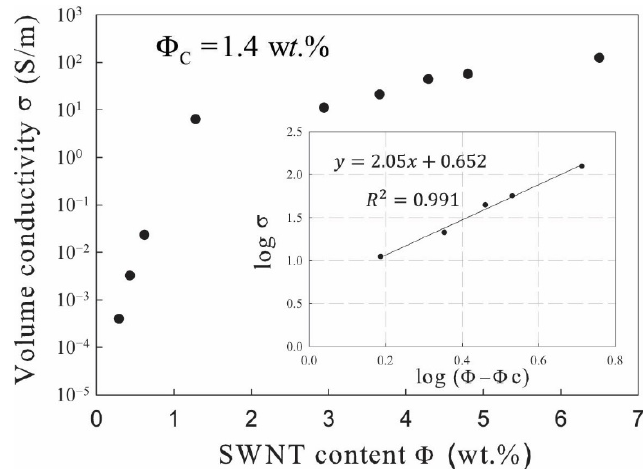
Figure 8. Electrical conductivity as a function of SWNT content.